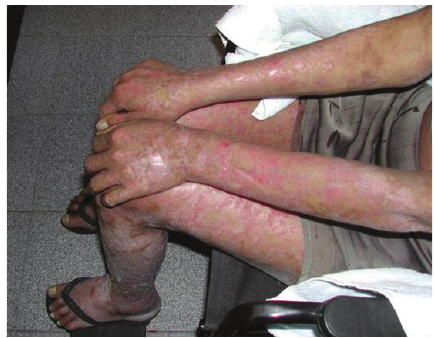
Figure 1: Desquamative and nonpruritic lesions in